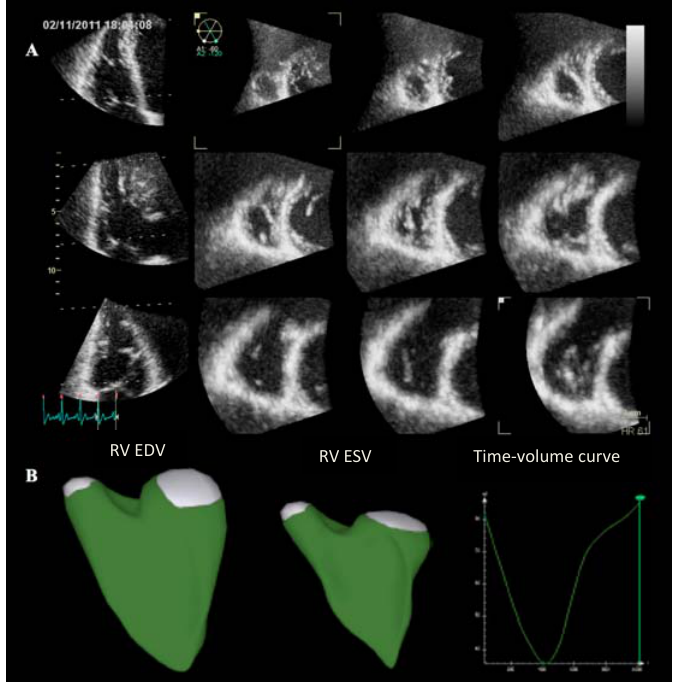
Figure 3. Three-dimensional echocardiographic visualization of the right ventricle in a healthy subject. ( A ) Multislice view showing three apical views and corresponding short axis. ( B ) Right ventricular beutel in end-diastole and end-systole and the corresponding time- volume curve. EDV = end-diastolic volume; ESV = end-systolic volume; RV = right ventricle.